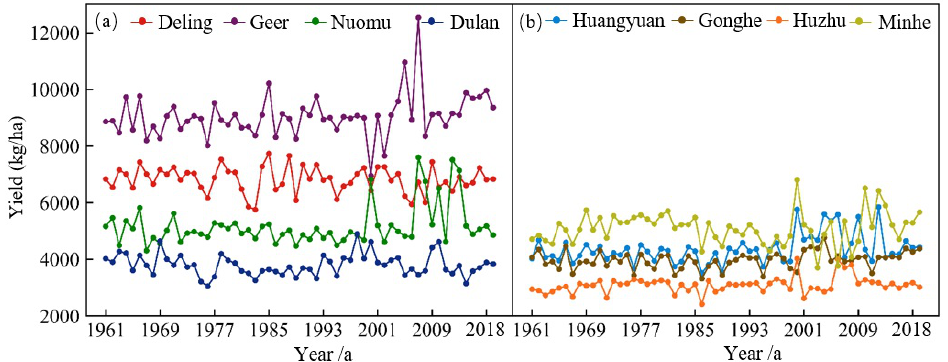
Figure 8. The annual variations of simulated (climatic) yields over 1961–2018 for the 8 selected sites. (( a ) The 4 sites in the figure are located in the Qaidam Basin, and ( b ) the 4 sites in the figure are located in eastern Qinghai